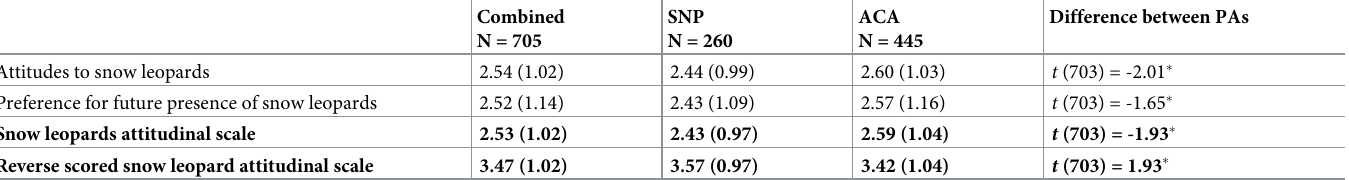
Difference between PAs